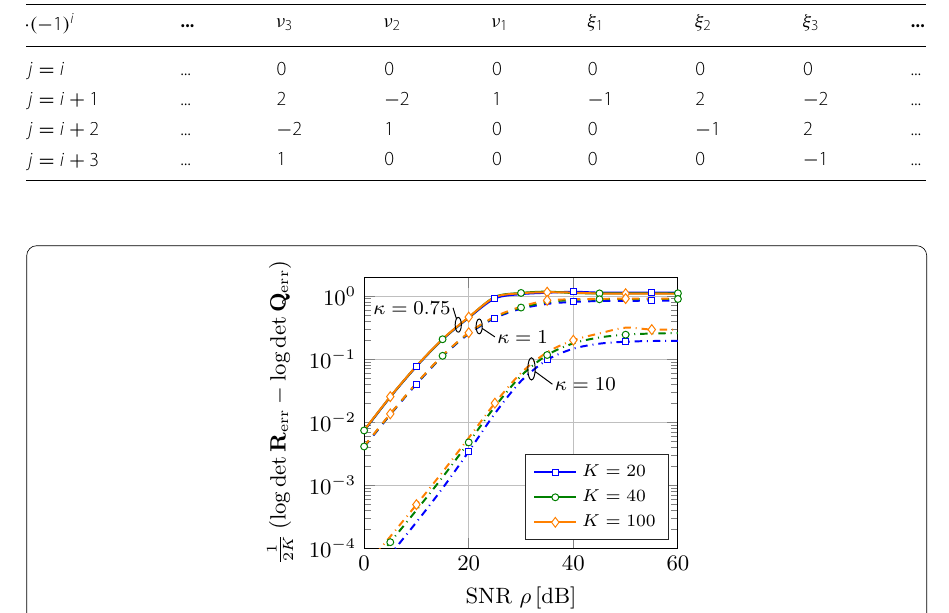
Fig. 11 Difference between the two bounds in (62) and (63). The difference is normalized by the blocklength W / (cid:31) and different K ; it is always non-negative K and depicted for different κ =